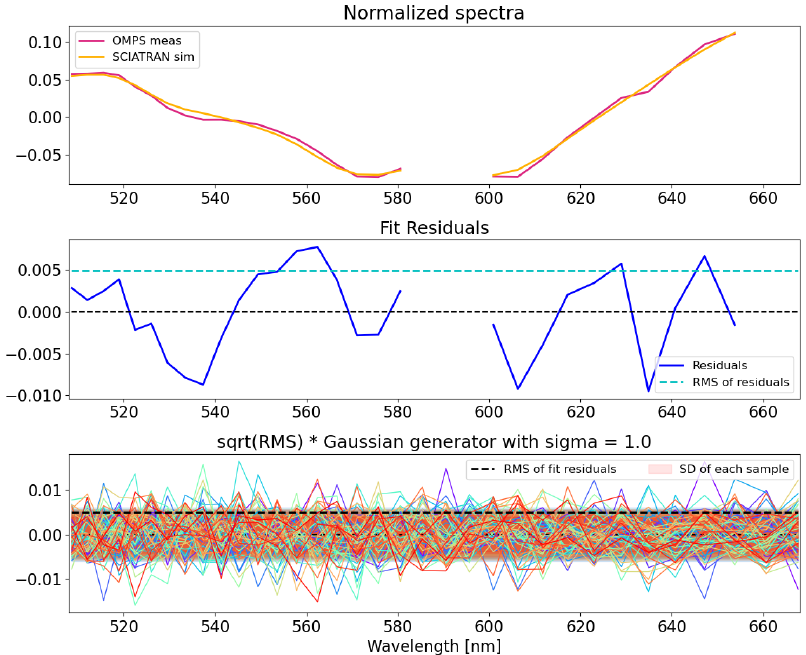
Figure 3. Example of spectra, fit residuals, and randomly generated noise sequences (multiplied by square root of the fit residuals (rms) is equal to the standard deviation (SD) of each generated noise